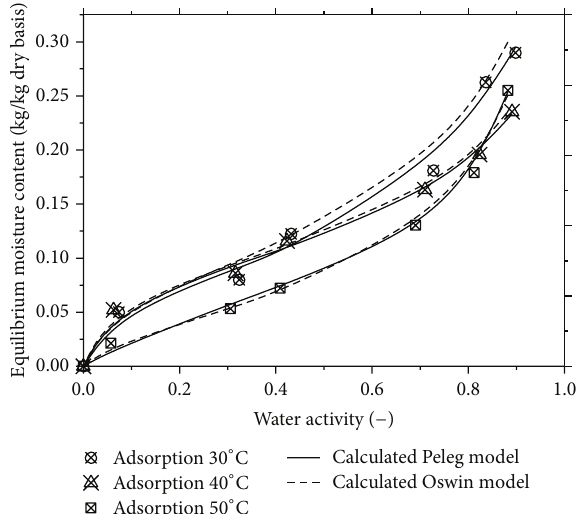
Figure 5: Comparison between experimental and calculated (Peleg and Oswin models) data of adsorption isotherms of Ziziphus spina- christi leaves obtained at 30, 40, and 50 ∘ C. Cal.: calculated.